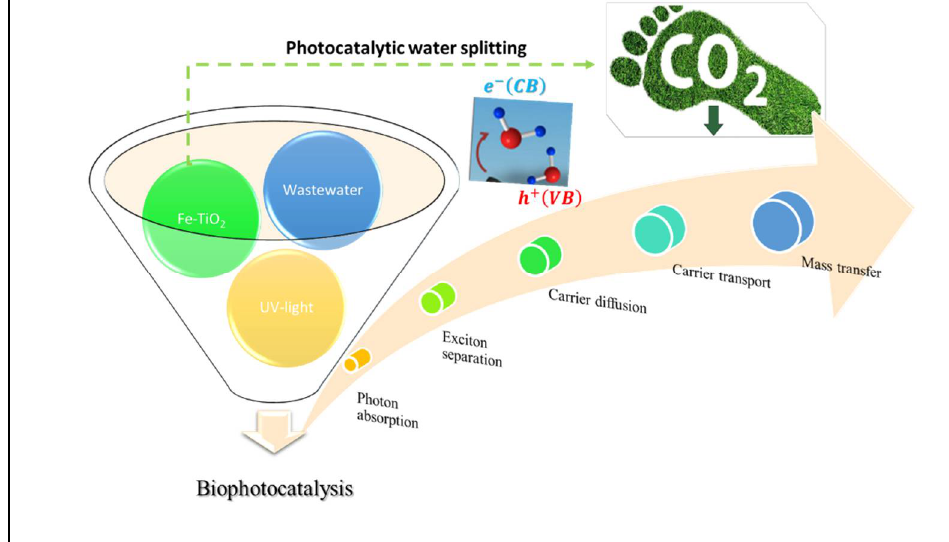
Figure 1. A schematic diagram of biophotocatalysis.